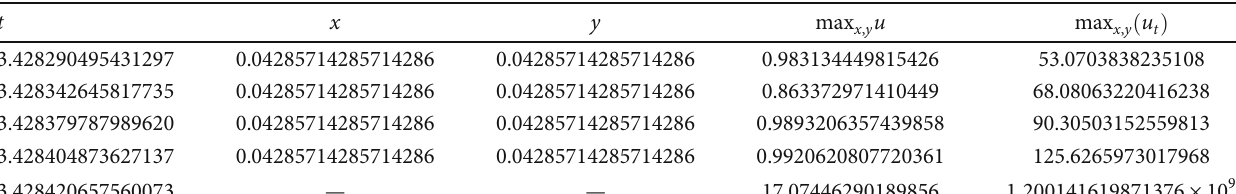
q = 1, b = b = 3, α = β = 15 based on convection term b / ð 1 + α x + β y Þ . t for x y